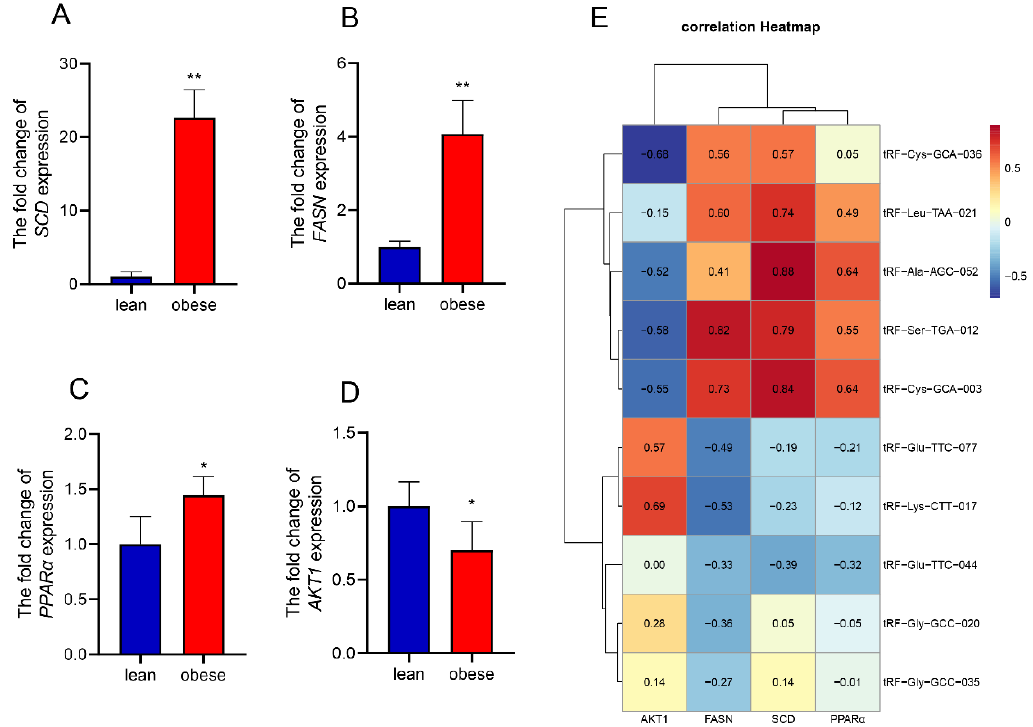
Figure 7. tsRNA regulatory network and correlation analysis. ( A – D ) Detection of relevant gene expression levels by RT-qPCR ( n = 6). ( E ) Heat map of correlation between tsRNA and selected genes in metabolic pathways. * p < 0.05, ** p < 0.01.